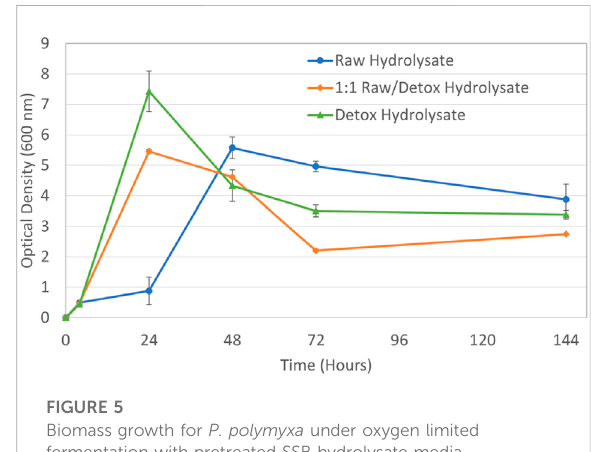
FIGURE 5 Biomass growth for P. polymyxa under oxygen limited fermentation with pretreated SSB hydrolysate